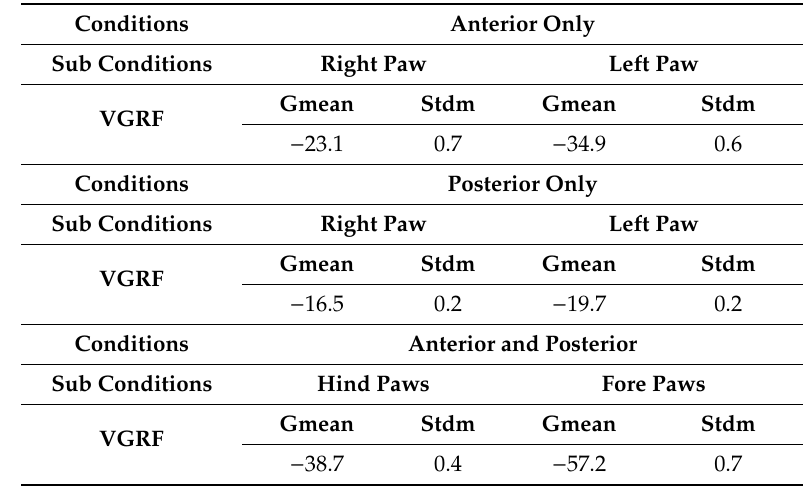
Table 1. Vertical ground reaction forces normalized to the dog’s weight computed for three di ff erent conditions, for a 10 s duration. Grand mean values and standard deviation of the means values over subjects are reported.